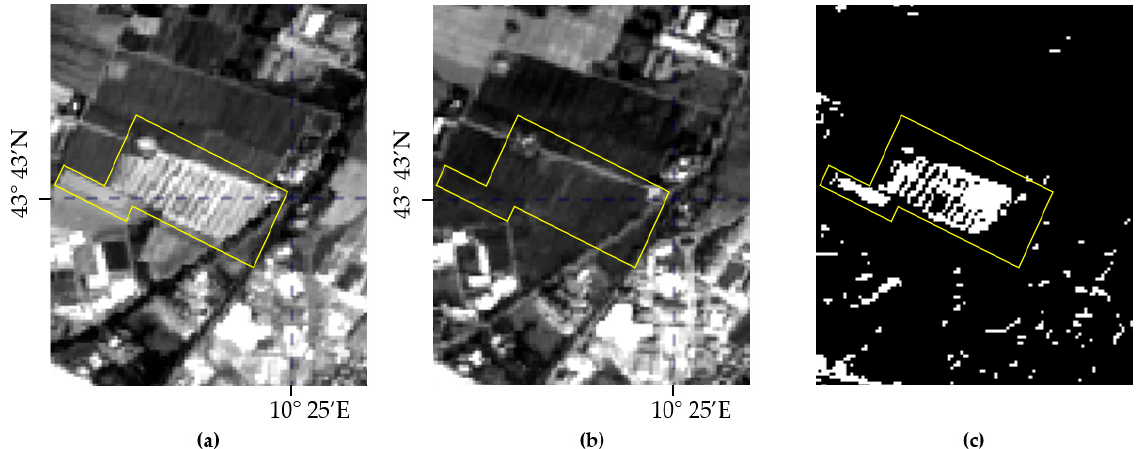
Figure 4. Example of an area used for the threshold determination: ( a ) the average value of the changed pixels in the yellow polygon is 1700 at time t 1 and ( b ) 740 at time t 2 . ( c ) Binary image obtained with 1000 as threshold value (changed areas are shown in white).